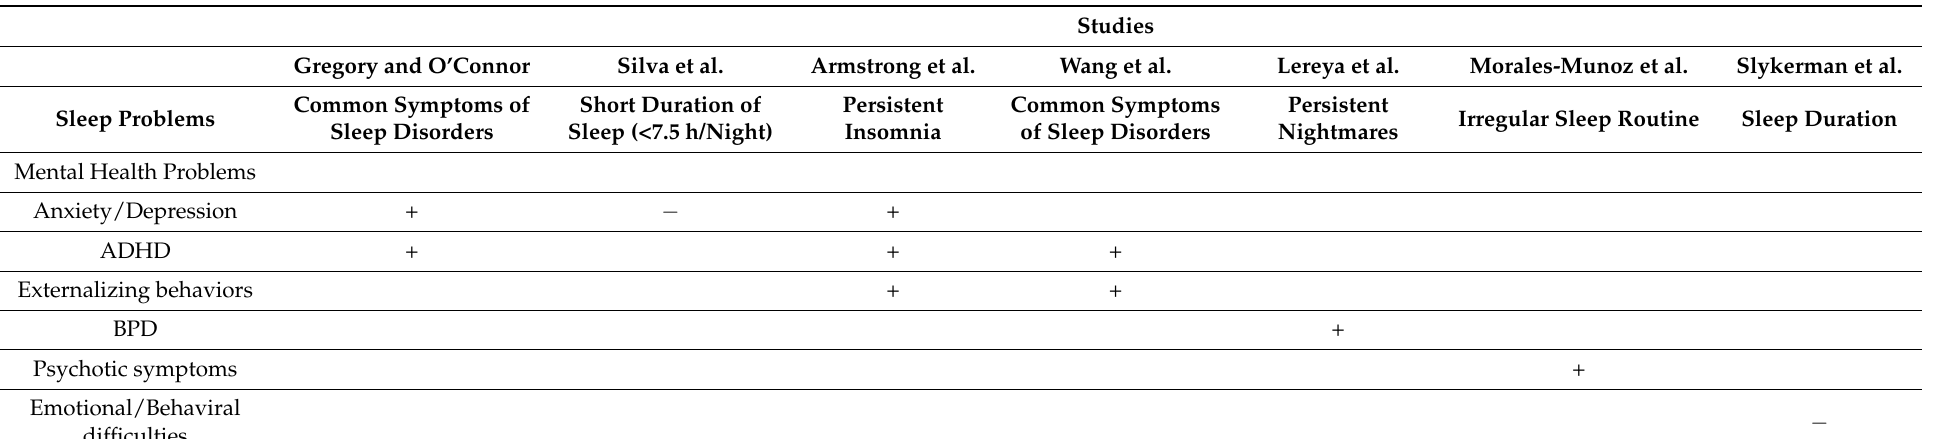
Table 2. Summaries on the relationships between early childhood sleep problems and adolescent mental health resulting from the review of the selected